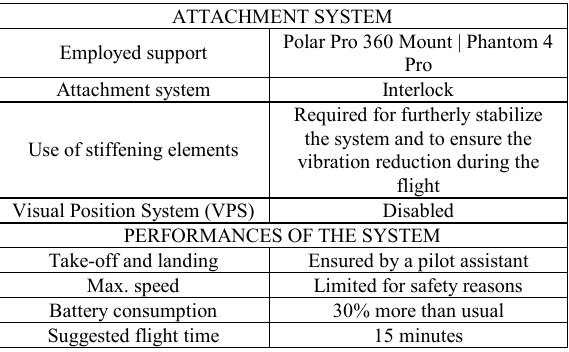
Table 2. GoPro Fusion main specs.